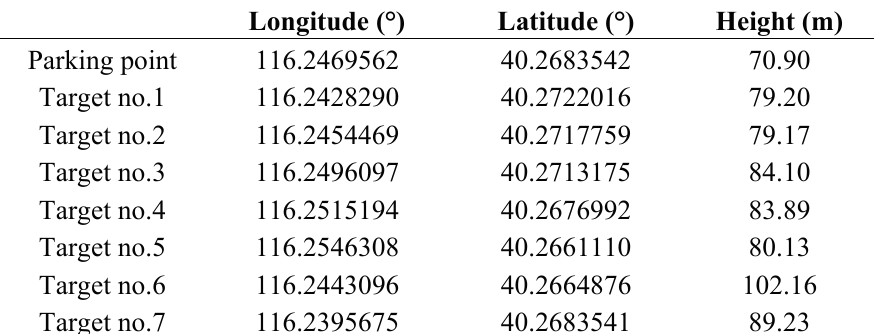
Table 1. Positions of the targets and parking